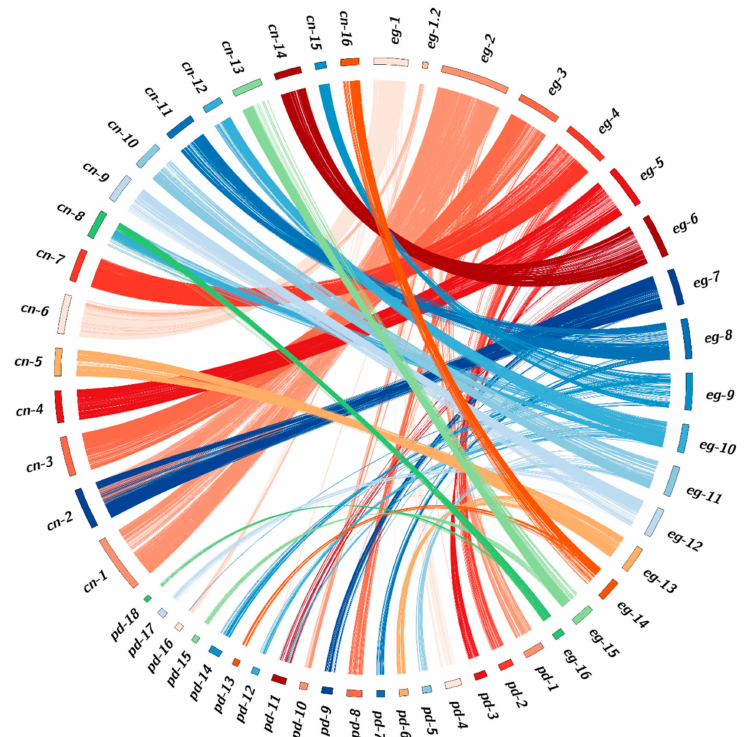
Figure 2. Synteny analysis including three palm species: oil palm (eg), coconut (cn), and date palm (pd). Chromosome pairs with strong syntenic relations were linked by the same ribbon